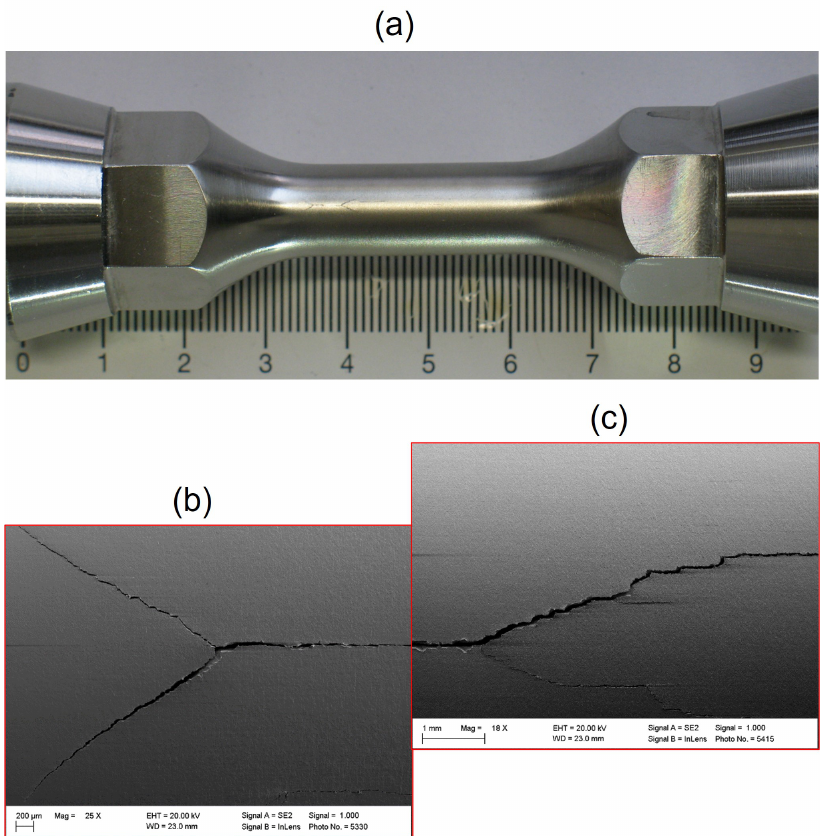
Figure 7. Specimen after 7500 cycles at 250 MPa and max. torsional angle of 15 ◦ . ( a ) Test section ap- pears dull due to surface deformation, ( b ) crack branching and ( c ) fine cracks parallel to longitudinal axis are visible.